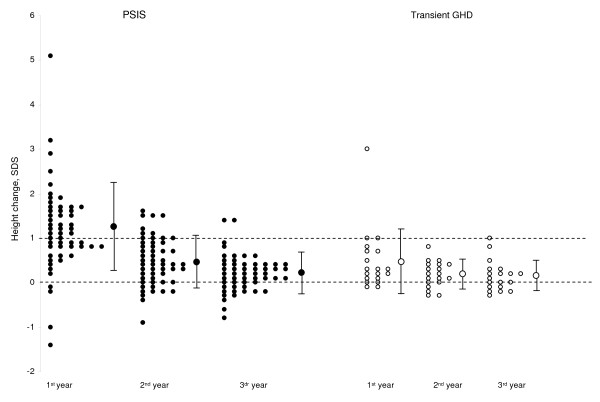
Annual changes in height during the first three years of GH treatment.